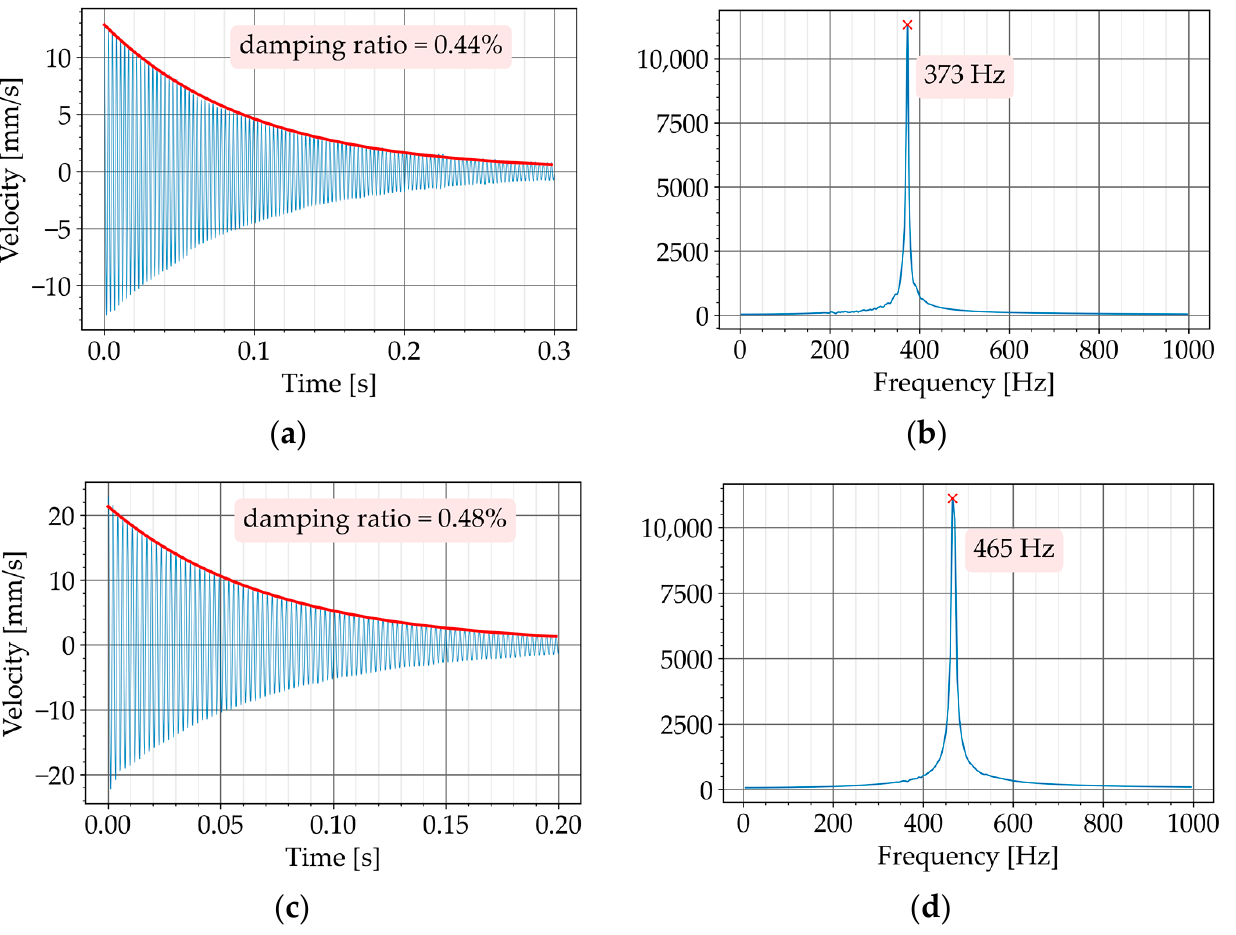
Figure 11. Decaying free vibration of the beams without the damper and their FFT diagrams (first step of the free vibration test). ( a ) P670: free vibration without damper. ( b ) P670: FFT of signal in a. ( c ) P600: free vibration without damper. ( d ) P600: FFT of signal in c.